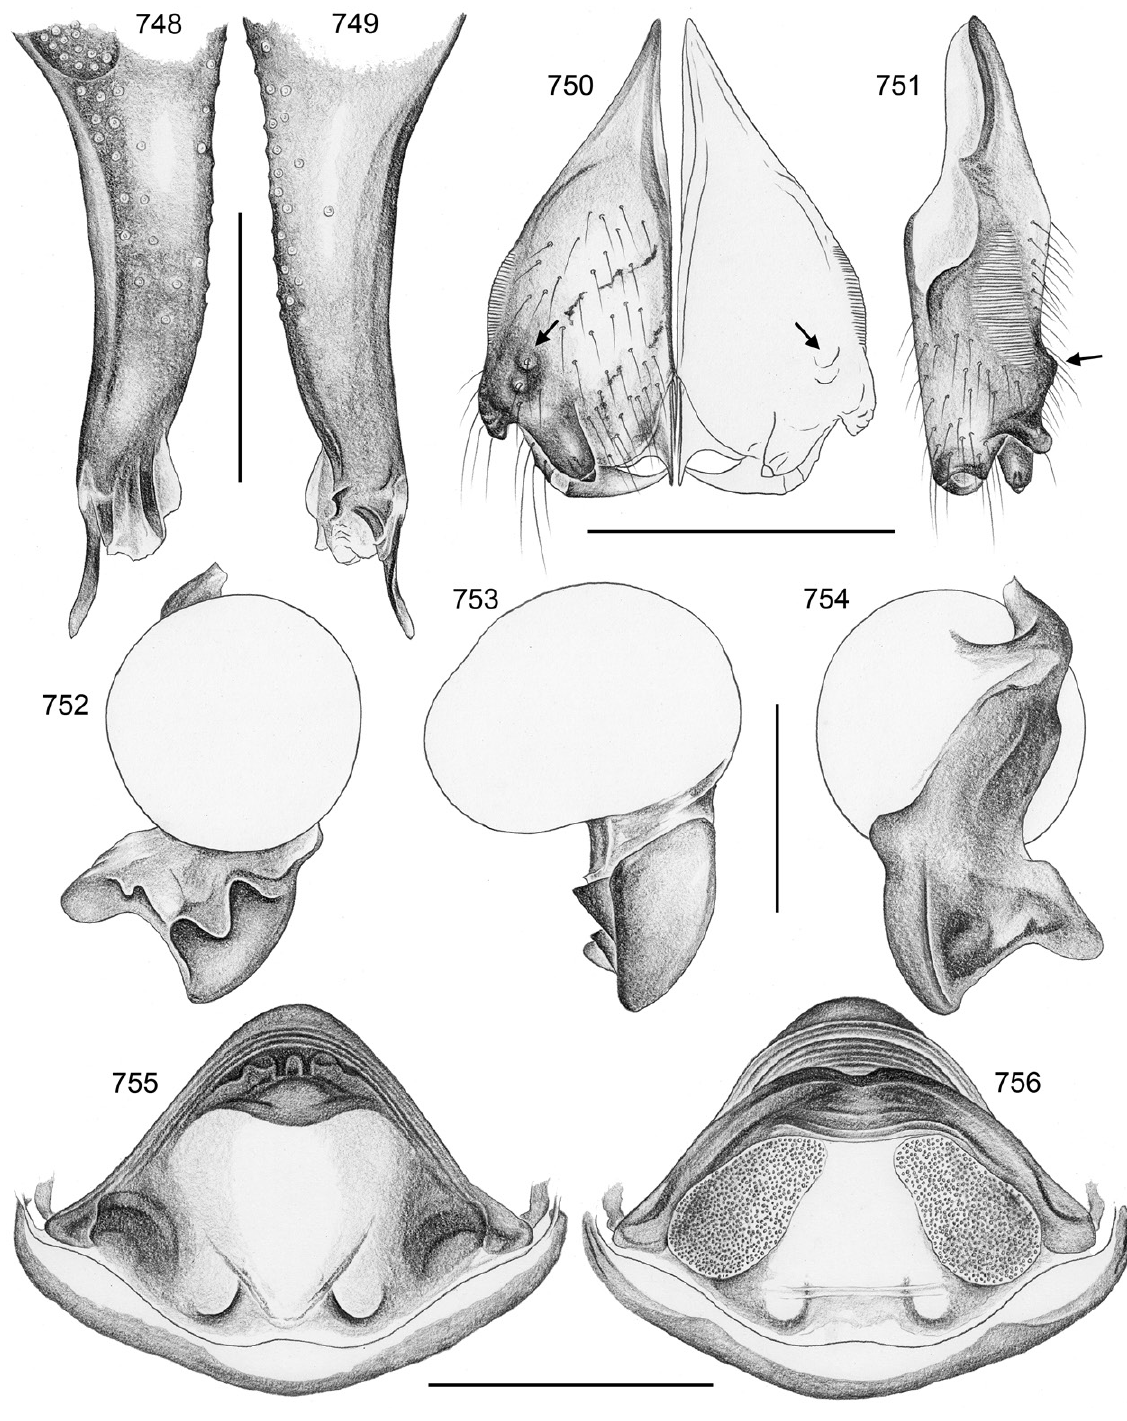
Figs 748–756. Crossopriza srinagar sp. nov.; holotype male and female from India, Srinagar (ZFMK Ar 22449, Ar 22450). 748–749 . Left procursus, prolateral and retrolateral views. 750–751 . Male chelicerae, frontal and lateral views; arrows: frontal humps near lateral apophyses. 752–754 . Left genital bulb, prolateral, dorsal, and retrolateral views. 755–756 . Cleared female genitalia, ventral and dorsal views. Scale bars: 748–749, 752–754 = 0.3 mm; 750–751, 755–756 = 0.5